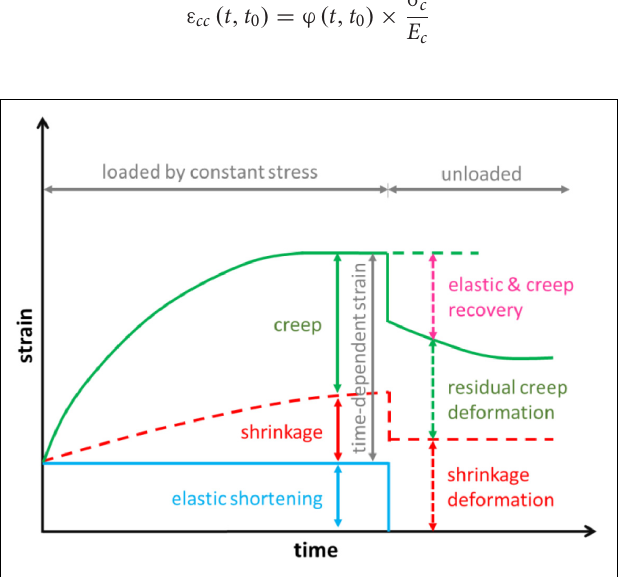
FIGURE 1 | Creep strain over